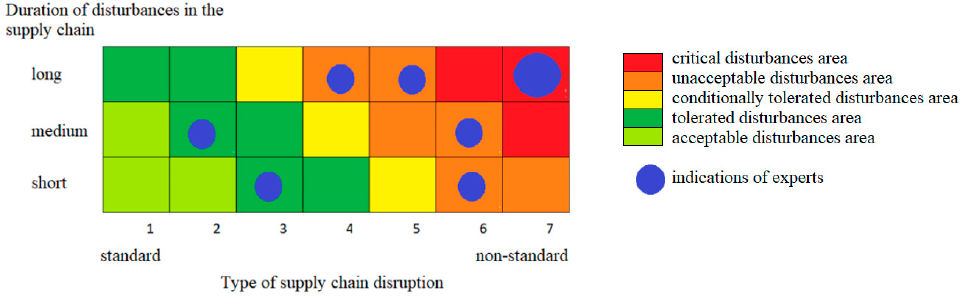
Figure 5. Duration of the supply chain disruption and its type.